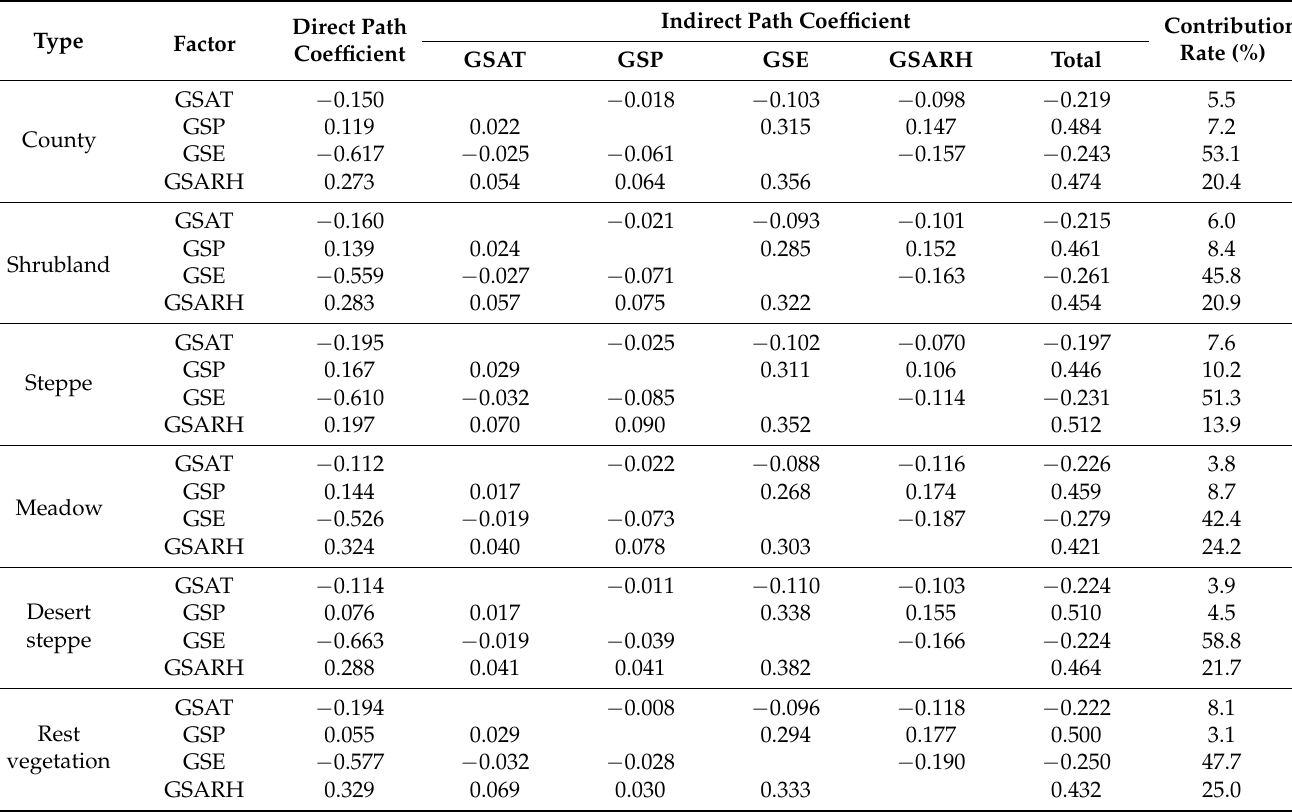
Table 2. Path analysis between growing season NDVI and climate